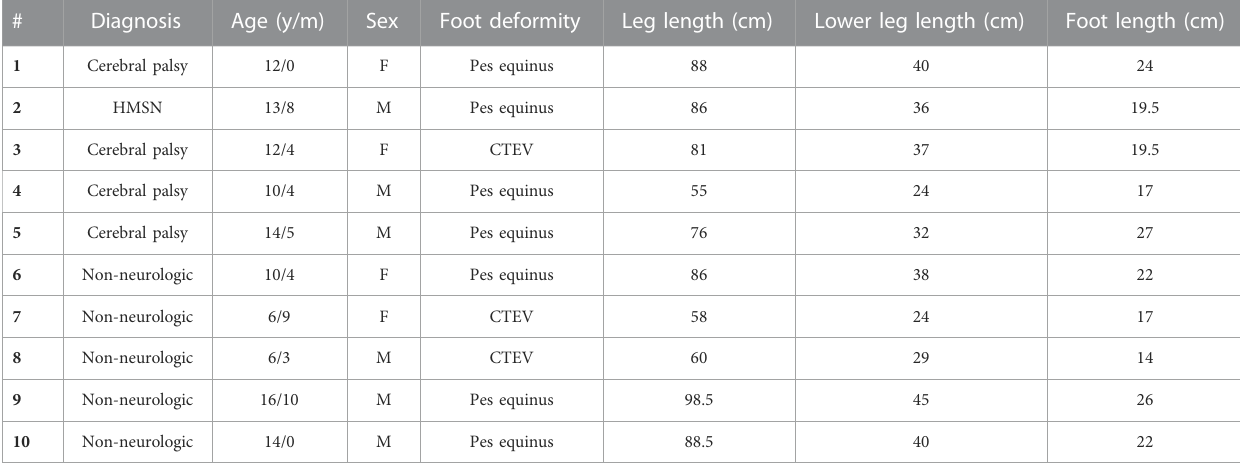
TABLE 1 Patient characteristics.